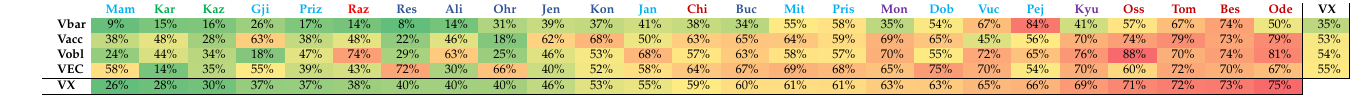
Table 1. Distribution of verb–dependent orders in main clauses across Balkan